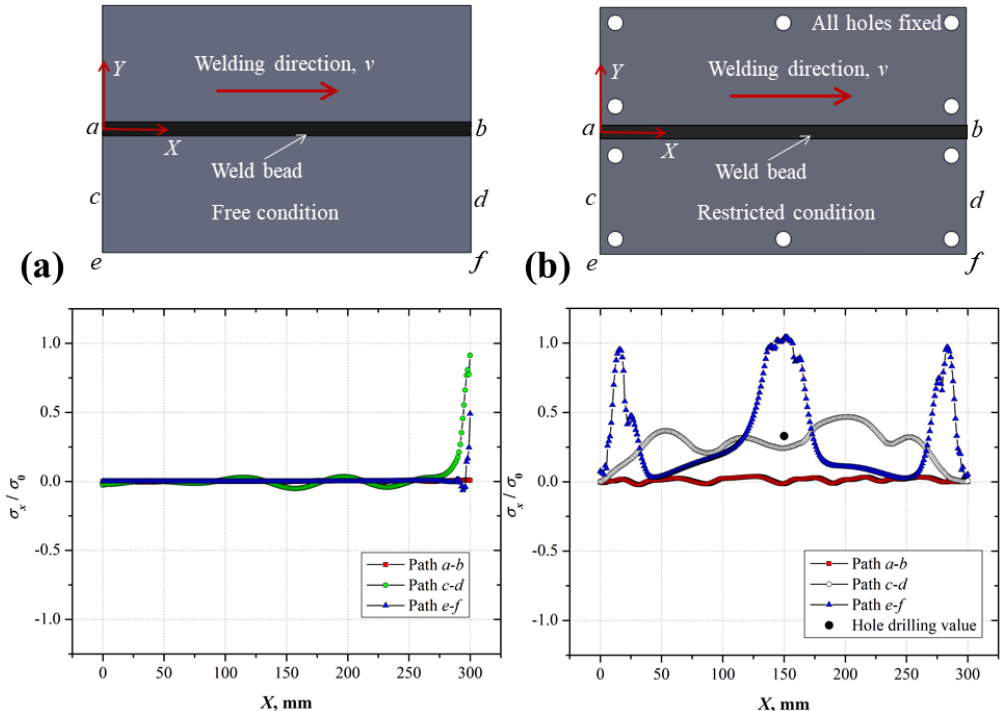
Figure 17. Normalized longitudinal residual stresses ( σ x ) as a function of yield stress ( σ 0 ) of the 3003-H14 aluminum alloy: ( a ) free welding condition and ( b ) restricted condition. The normalized transverse residual stresses ( σ y ) as a function of yield stress ( σ 0 ) for the 3003-H14 aluminum alloy are shown in Figure 18.